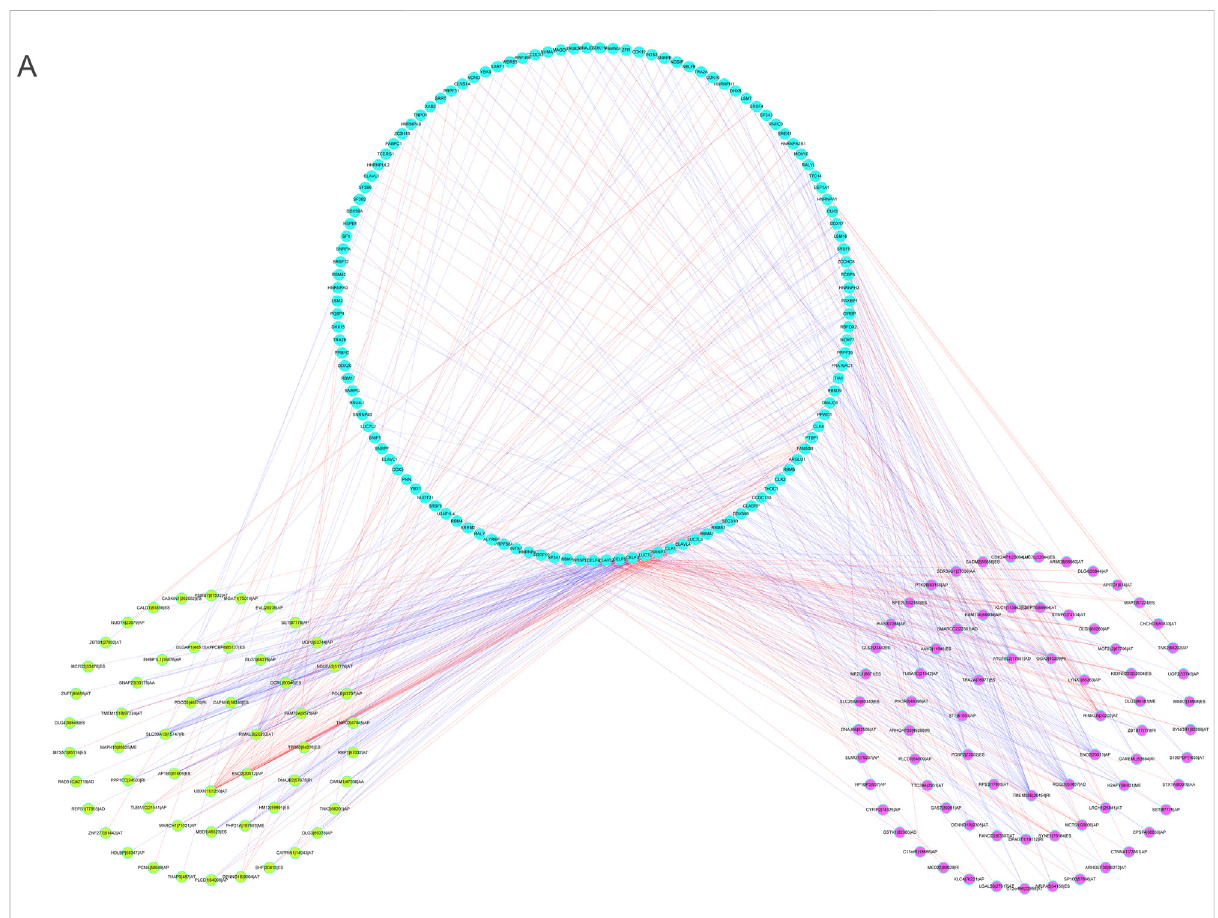
FIGURE 12 (A) . The regulatory network between splicing factors and m6A methylation regulator-associated AS